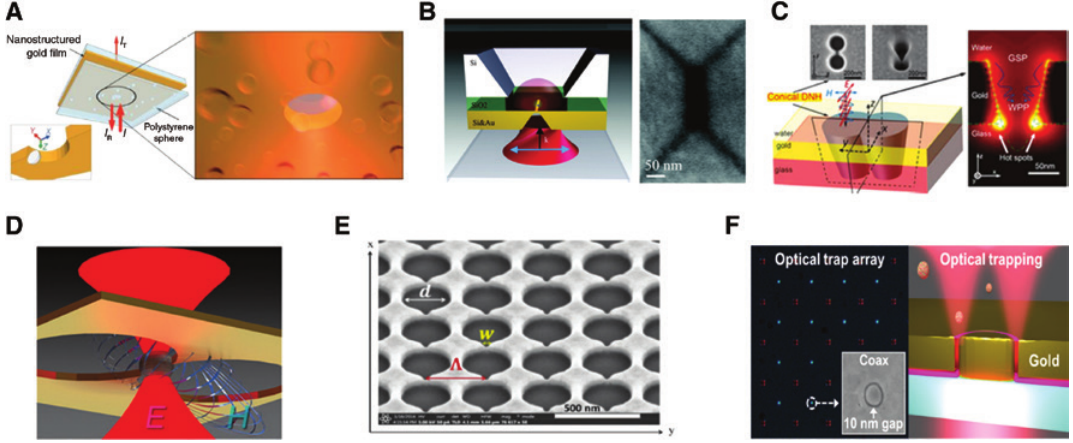
Figure 3: Nanoaperture Plasmonic Tweezers